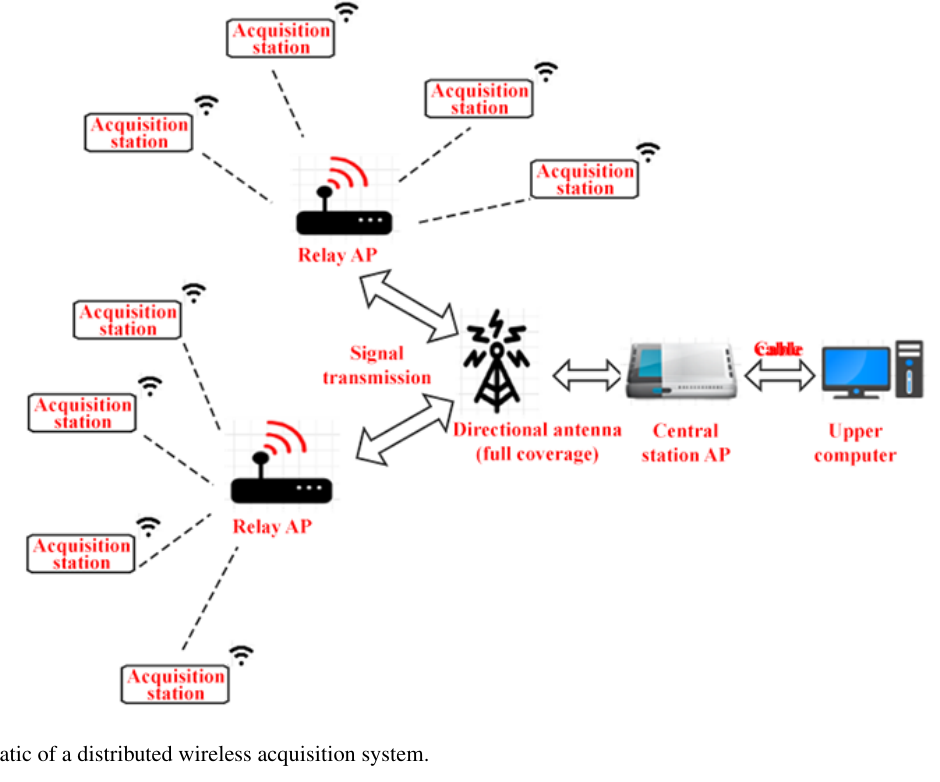
Figure 6. Schematic of a distributed wireless acquisition